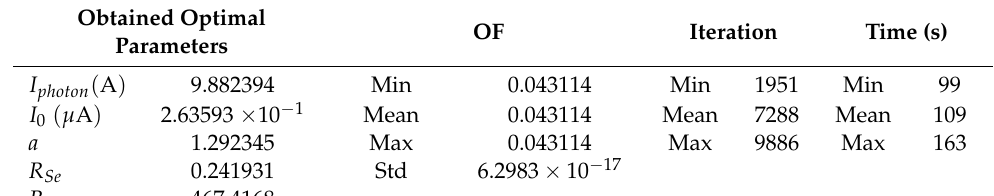
Table 10. Obtained statistical results of SDM JKM330P-72 PV module for curve 1. Table 13. JKM330P-72 DDM PV module statistical results for all respective curves.